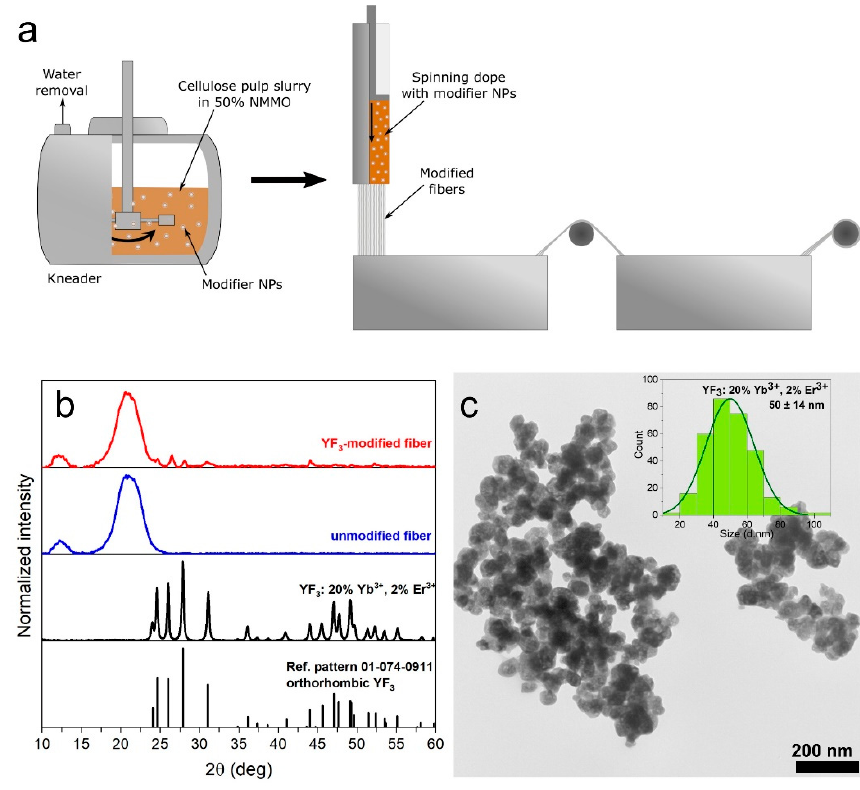
Figure 1 . ( a ) Scheme of the formation of the upconversion cellulose fibers; ( b ) powder XRD patterns of modifier NPs, and modified and unmodified cellulose fibers; ( c ) TEM image of YF 3 NPs; inset shows size distribution of NPs.